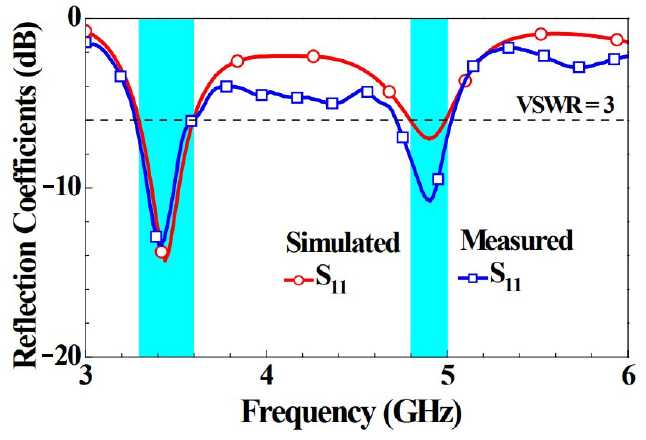
Figure 5. Simulated and measured reflection coefficients for Ant